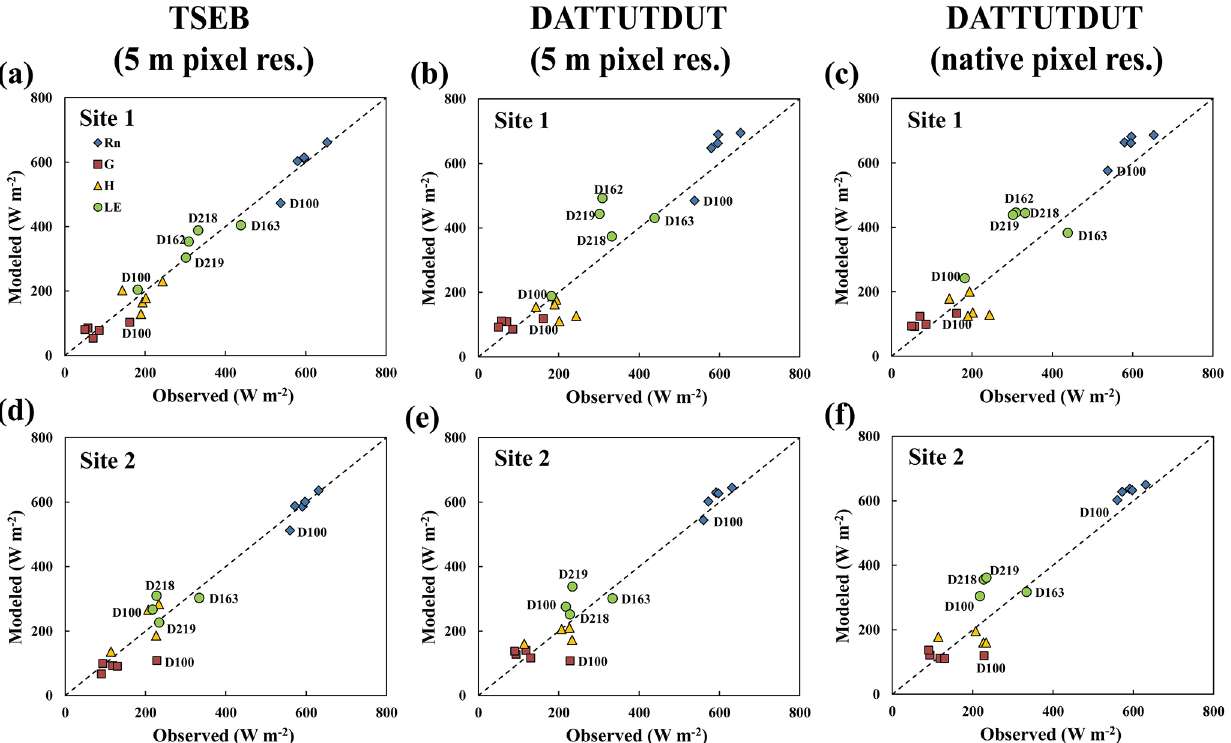
Figure 6. Scatter plots of observed and modeled fluxes from (a) TSEB (5m pixel resolution), (b) DATTUTDUT (5m pixel resolution) and (c) DATTUTDUT (native pixel resolution) at the aircraft overpass time for the 5 days in 2013. The observed H and LE use the RE method for energy balance closure. Note for DOY 162, there were no flux data from site 2 due to an EC sensor